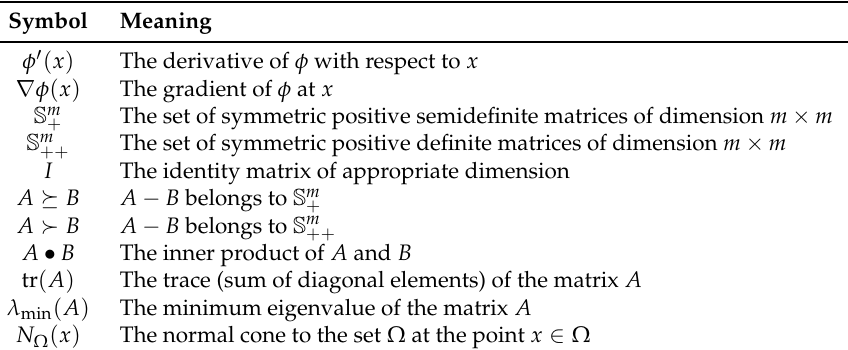
Table 1. Mathematical symbols and their